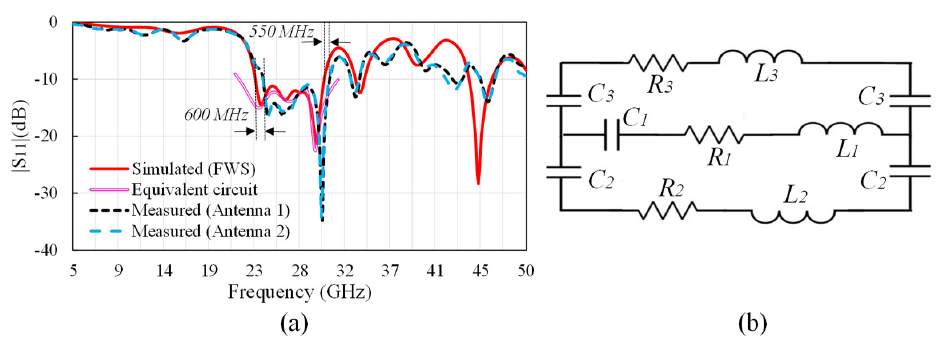
Figure 10. ( a ) Comparison of theoretical (using a full—wave simulator, FWS), equivalent circuit, and experimental reflection coefficient at the input port of the proposed design; and ( b ) the proposed equivalent circuit suitable for the 23 to 30 GHz frequency range .